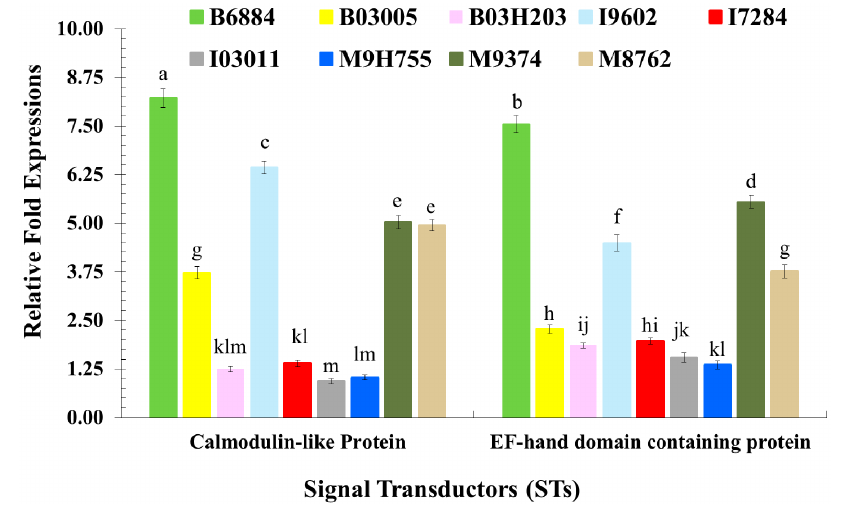
Figure 4. Relative fold-expression of signal transductors of Rhynchophorus ferrugineus larvae in response to fungal infections using quantitative real-time PCR. Means ± SE values followed by different letter(s) are significantly different. (Fisher’s Least Significant Difference (LSD) test, α = 0.05).